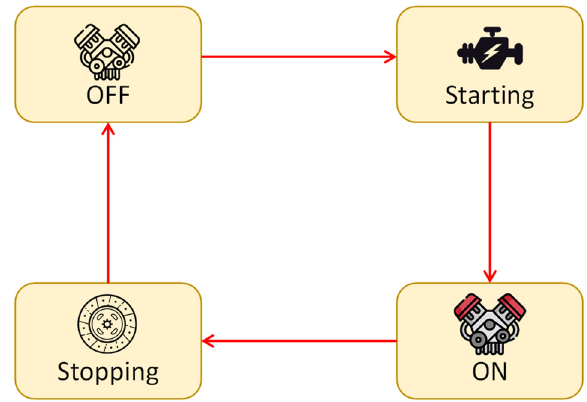
Figure 4. Engine finite-state machine scheme.